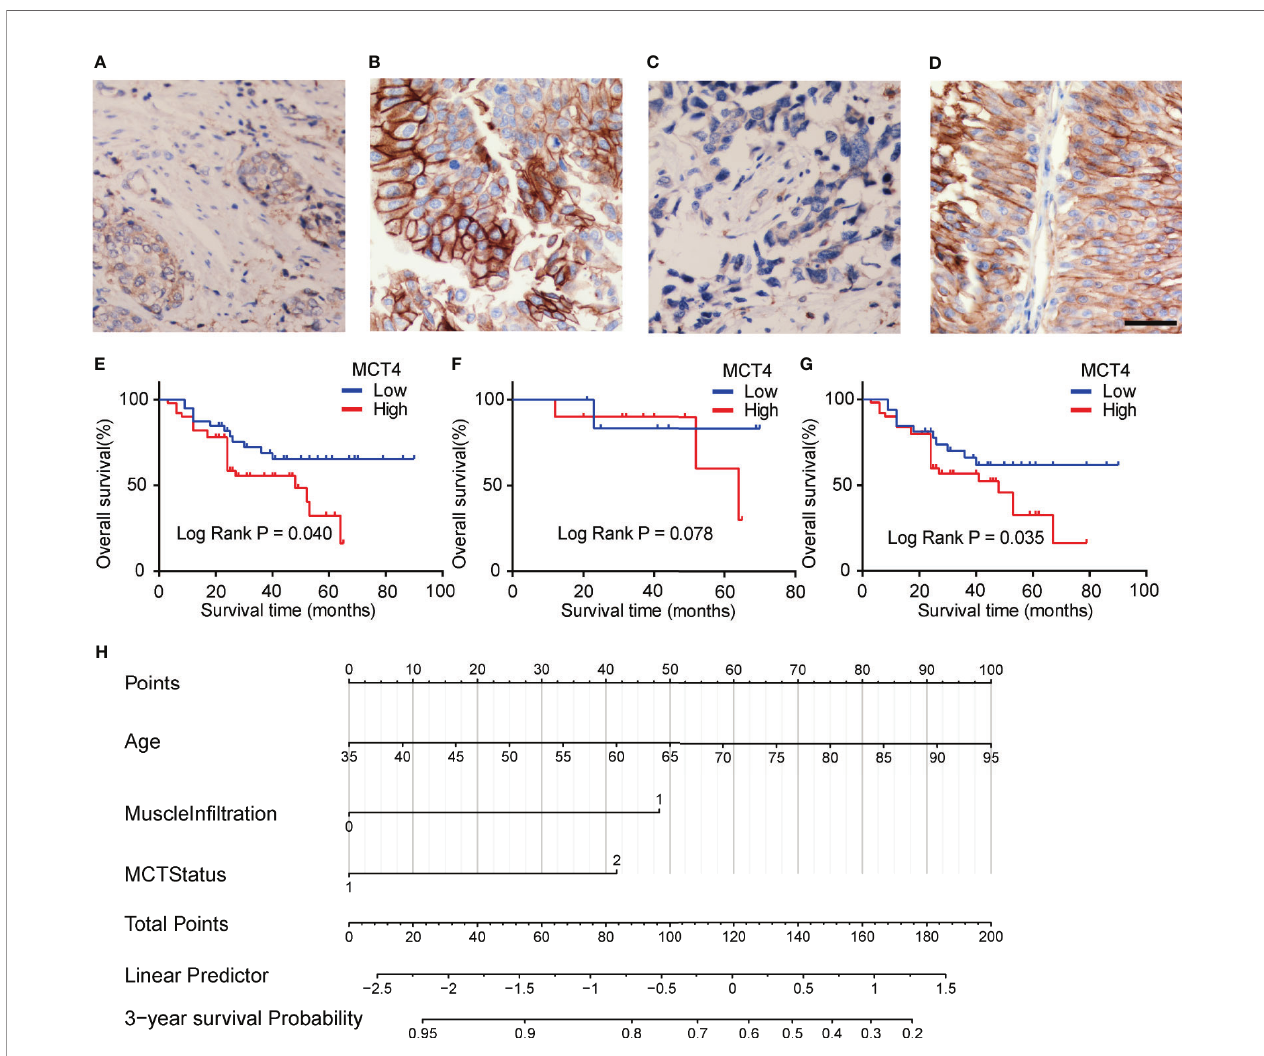
FIGURE 4 | Expression of MCT4 protein in bladder cancer. Low MCT4 (A) and high MCT4 (B) expression in non-muscle invasive bladder cancer (NMIBC). Low MCT4 (C) and high MCT4 (D) expression in MIBC. Magni fi cation: ×400. Scale bar: 10 m m. (E) High MCT4 protein expressions were associated with poor overall survival (OS) in all bladder cancer patients who received radical cystectomy (log-rank test, p = 0.040). (F) No signi fi cant difference was found between the OS of NMIBC patients with high MCT4 protein expression and NMIBC patients with low MCT4 expression (log-rank test, p = 0.078). (G) MIBC patients with high MCT4 protein expressions have worse OS rates than those with low MCT4 expression (log-rank test, p = 0.035). (H) Nomogram to predict the postcystectomy survival of bladder cancer patients. Patients were scored according to age (0 – 100 scores), existence of MIBC (48 for MIBC and 0 for NMIBC), and MCT4 expression (0 for low MCT4 expression and 42 for high MCT4 expression). The scores were then summed to obtain the total points; and the number in the last line, which is vertically beneath the accumulated total points, is the predicted 3-year survival for this